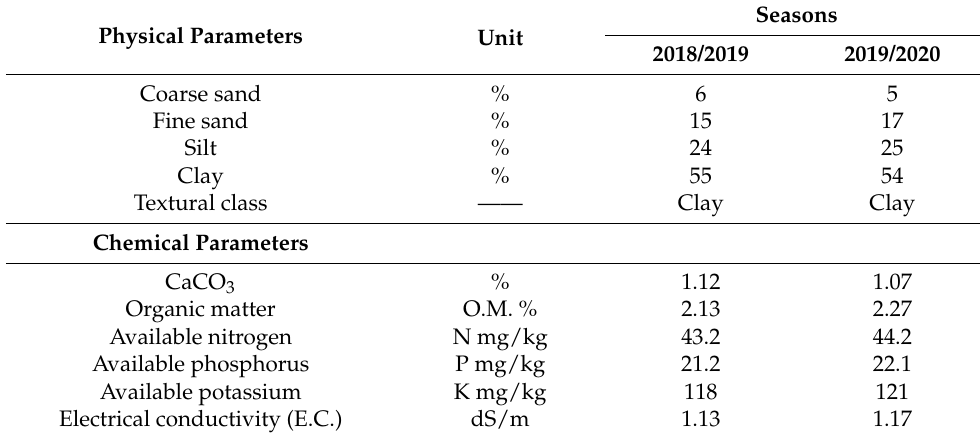
Table 1. Physical and chemical analysis of the experimental